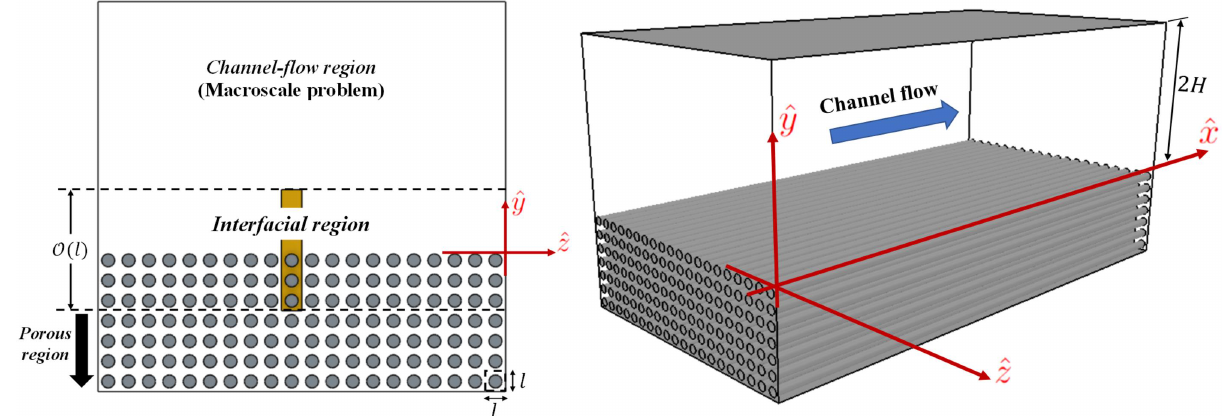
Figure 1. Sketch of the full domain for the case of streamwise-aligned cylindrical inclusions. The left frame illustrates in a constant ˆ x -section the decomposition of the domain into three distinct sub- regions; the brown volume represents the doubly periodic elementary cell of the microscopic